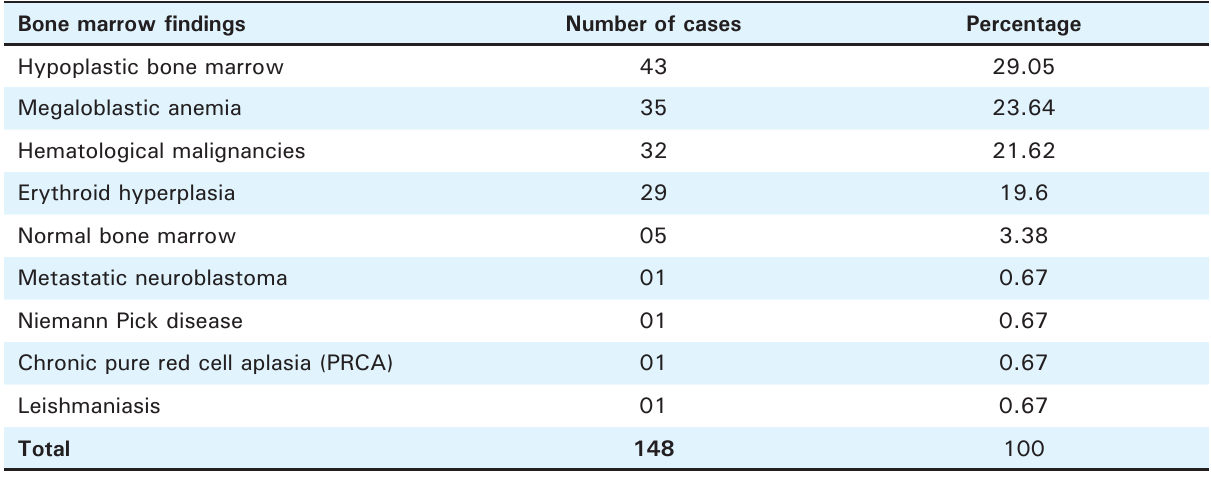
Table 1. Bone marrow aspiration fi ndings in cases of pancytopenia Bone marrow fi